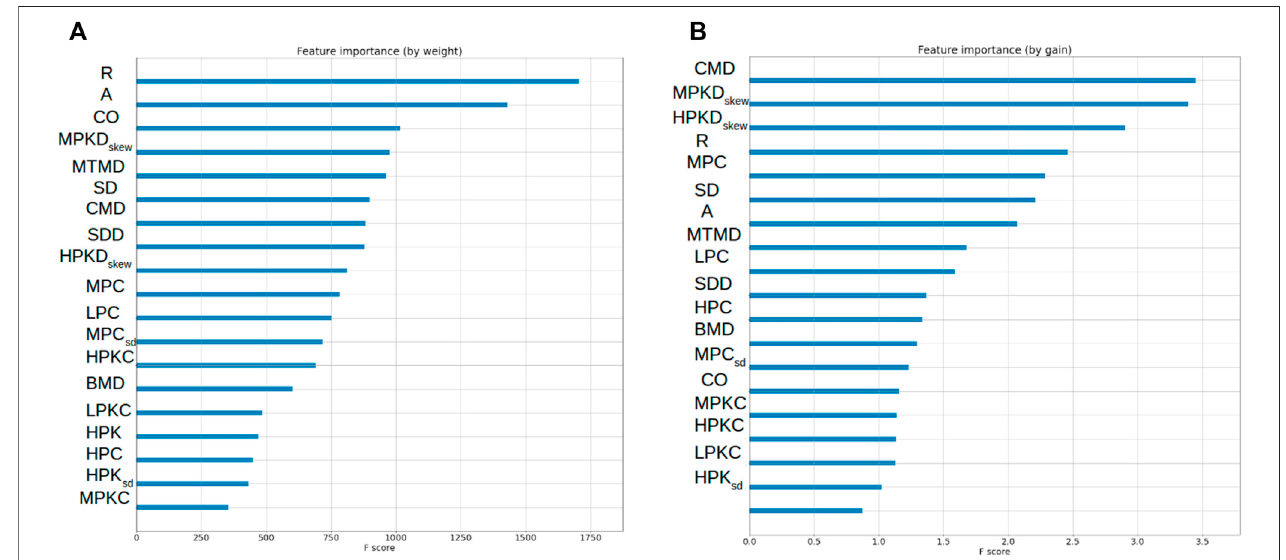
FIGURE 17 | Feature importance by weight (A) and gain (B)